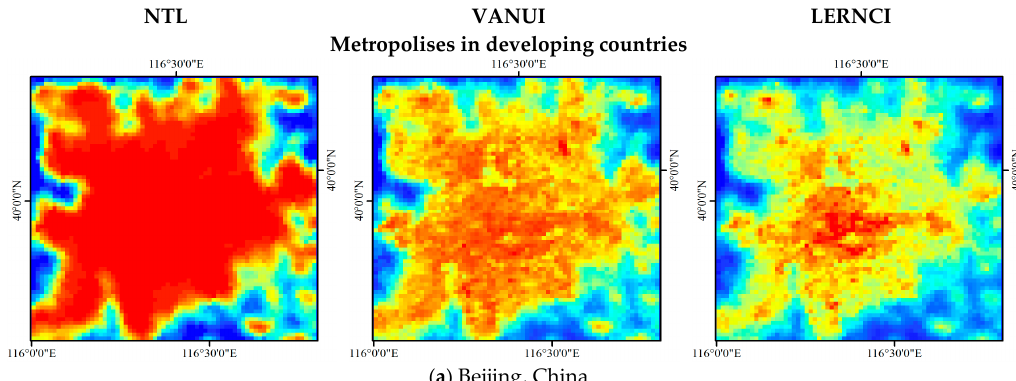
Figure 3. Operational Linescan System of the US Defense Meteorological Satellite Program (DMSP/OLS) NTL image of the world in 2013 and samples selected from NTL saturated areas.